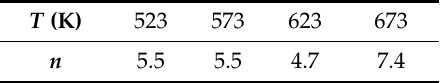
Figure 10d. The stress exponent n for AZ91 alloy can be obtained by linear regression analysis of Figure 10c, as shown in Table 2. Table 2. The n values of AZ91